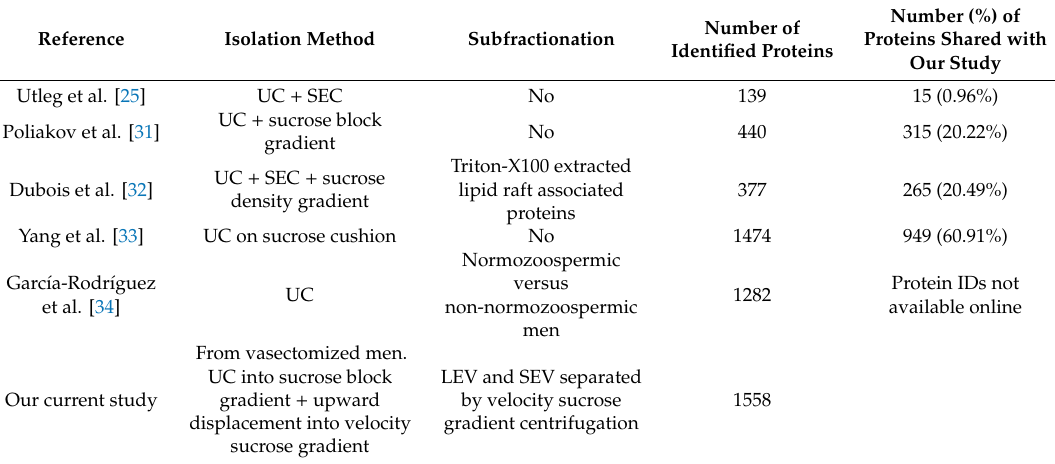
Table 1. Comparison of proteins detected large EV (LEV) and / or small EV (SEV) with previous MS / MS studies on the proteome of isolated human seminal plasma EV. Methods used include ultracentrifugation (UC) and size exclusion chromatography